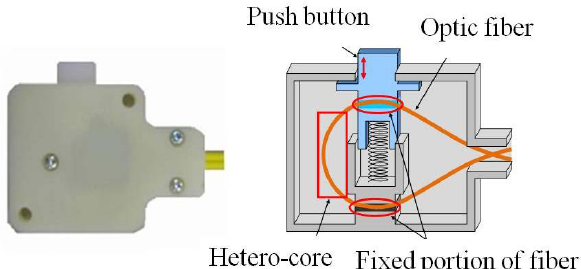
Figure 2. Structure of the binary switch